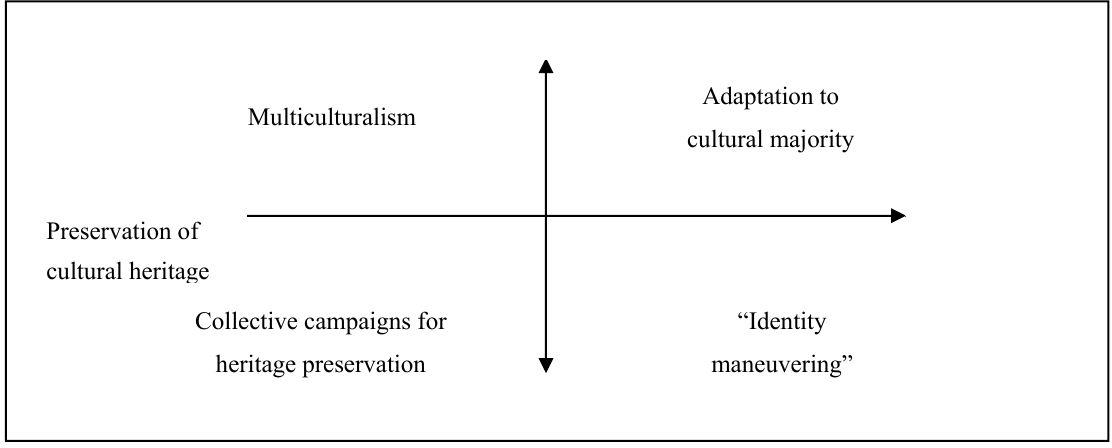
Figure 2. Model of integration strategies by F. M. Moghaddam [12].